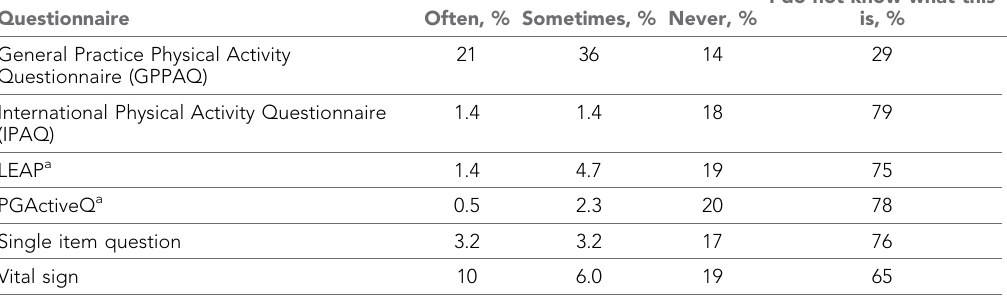
Table 4. ’Which of the following tools do you use to screen patients’ physical activity?’